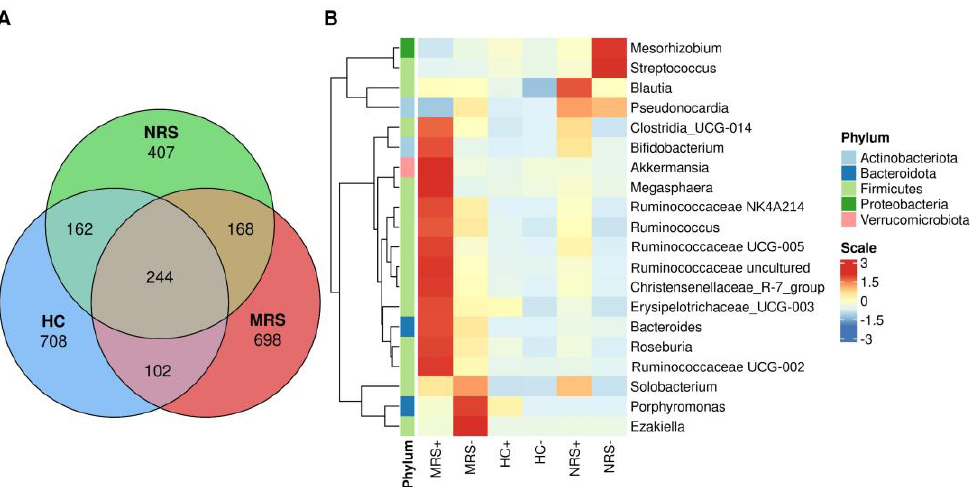
Figure 4. ( A ) Venn diagram showing shared taxa across MRS (mother rectal swab), red color, HC (human colostrum), blue color, NRS (neonate rectal swab), green color. ( B ) Differential frequency of bacteria in the studied samples. The heat-map highlights important taxa among MRS, HC, and NRS, while positive (+) or negative ( − ) SARS-CoV-2 genome detection by RT-ddPCR is shown beside the label. Columns show the abundance of the 20 bacterial genera with the best p -value ( p < 0.005) calculated by DESeq (differential gene expression based on the negative binomial distribution) and the phyla to which they belong. The color scale from blue ( − 3) to red (3) indicates the Wald Test coefficient calculated by DESeq from the feature table, with red more frequent. Color keys for phyla are shown on the right side of the figure. Actinobacteriota = Actinobacteria, Bacteroidota = Bacteroidetes.